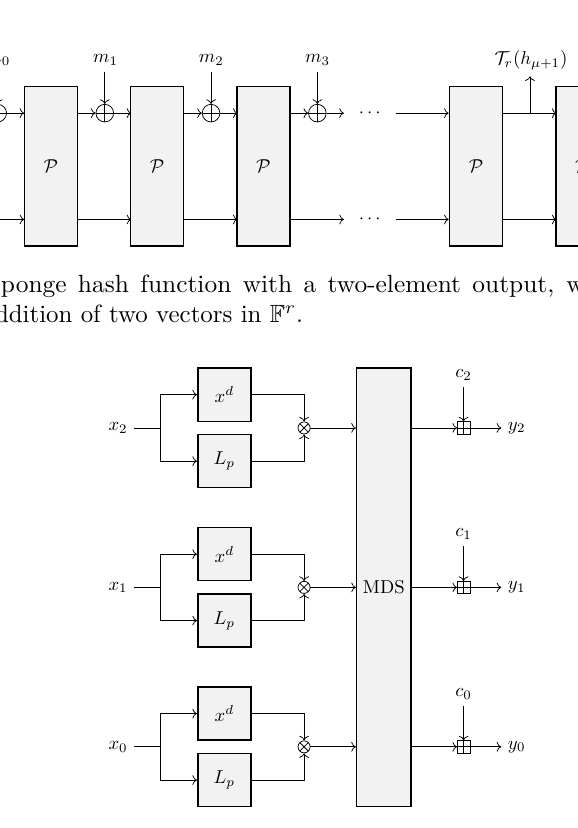
, where n = 3 and c i are round constants. p